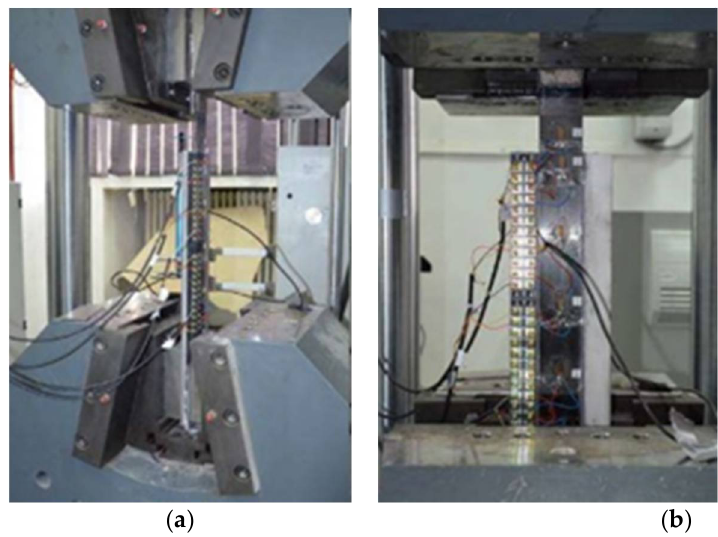
Figure 4. Test machine and specimen’s instrumentation. ( a ) Front view, ( b ) Lateral view.